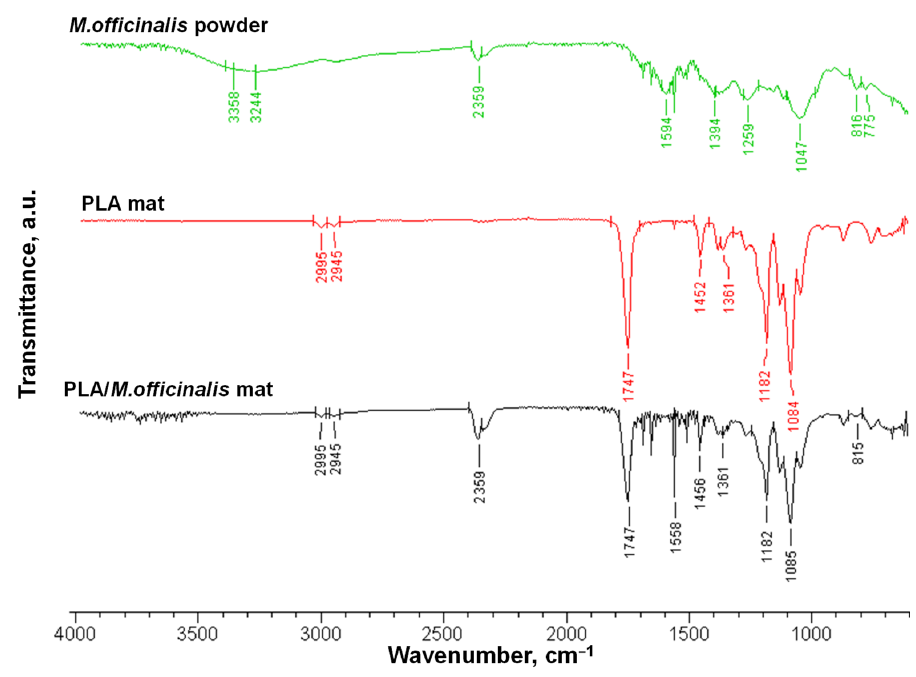
Figure 3. ATR-FTIR spectrum of M. officinalis (powder), PLA fibrous mat and PLA/ M. officinalis fi- brous mat. fibrous